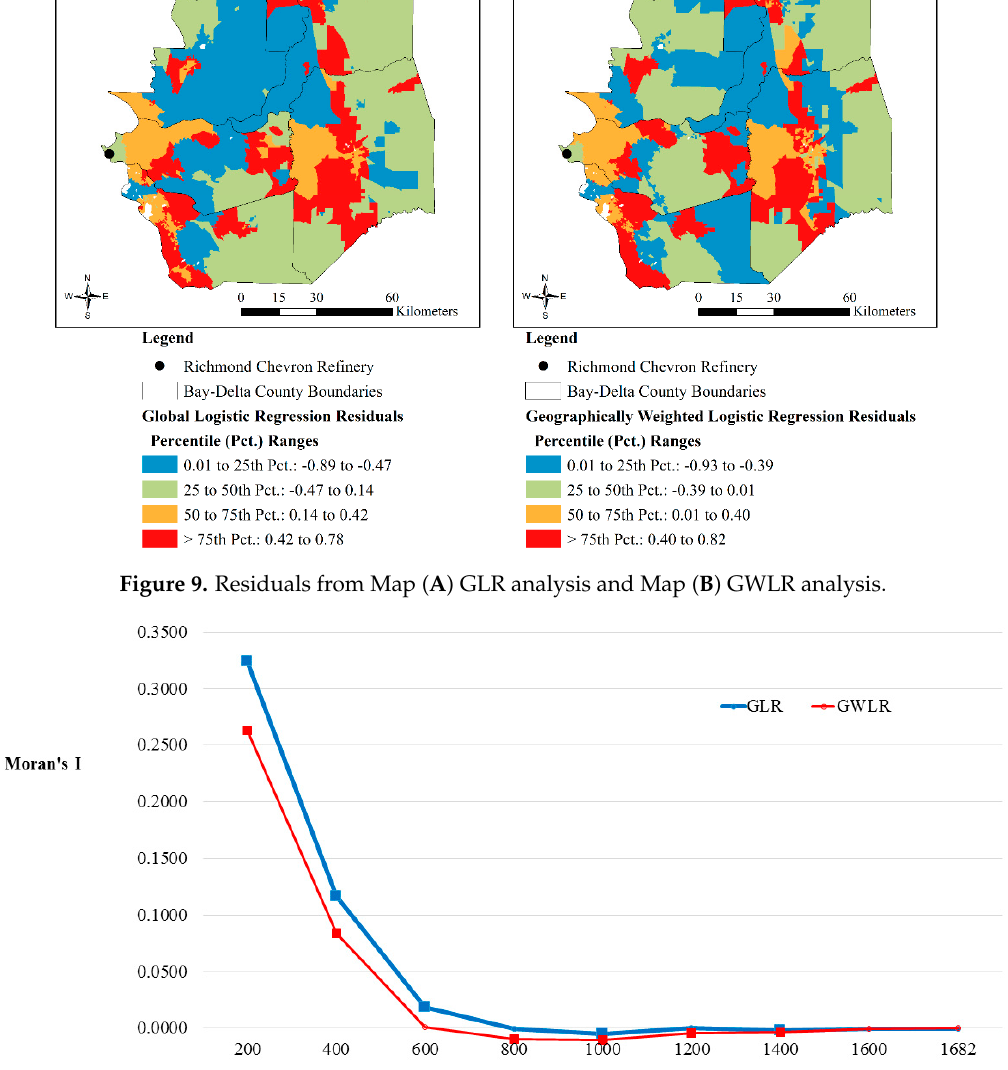
Figure 10. Results from spatial autocorrelation analysis of residuals from the GLR analysis and the GWLR analysis by nearest neighbor spatial weights matrix. Note : Square markers on trend lines indicate significant Moran’s I value ( p < 0.001; 9999 permutations).